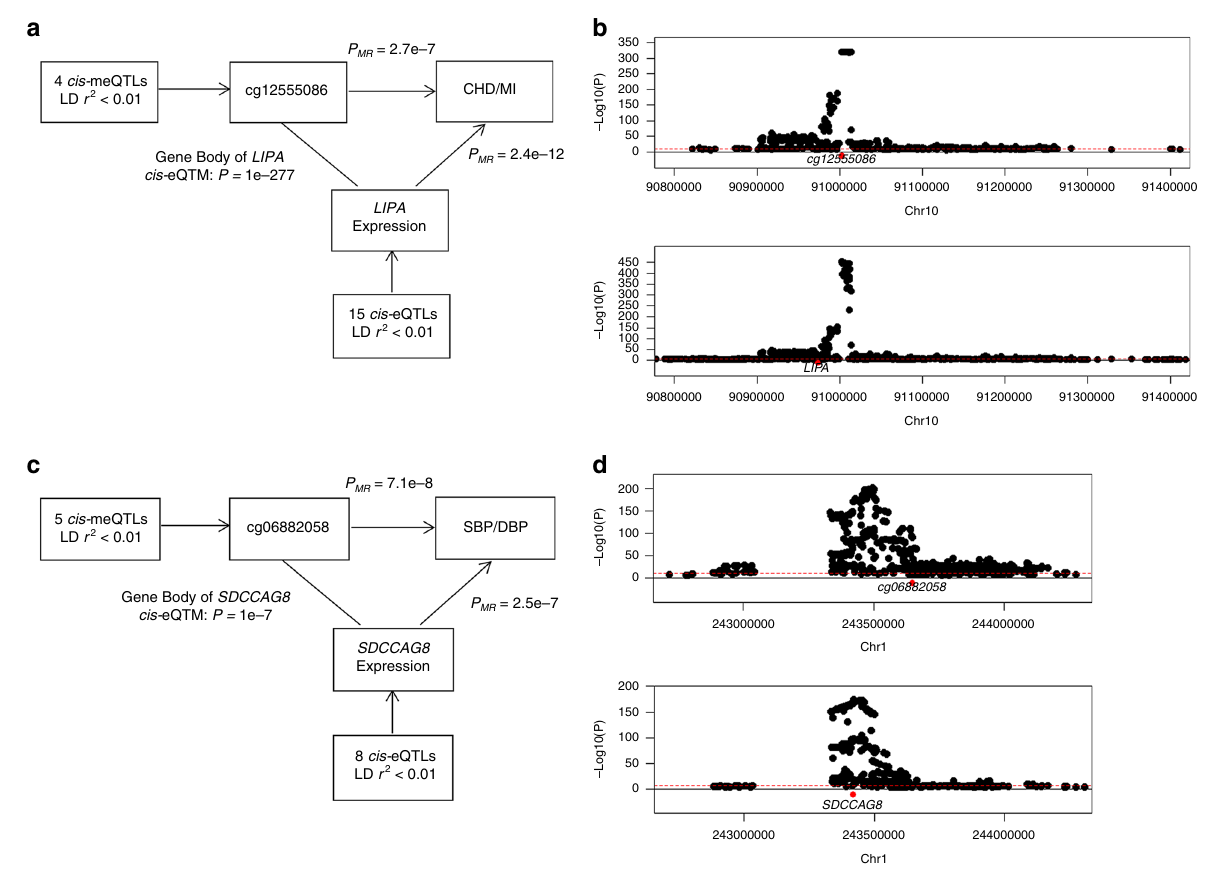
Fig. 6 Mendelian randomization examples. a MR example of cg12555086 in relation to CHD and MI; b colocalization of a casual cis- meQTL and a casual cis- eQTL on cg12555086 and LIPA expression; c MR example of cg06882058 in relation to SBP and DBP; d colocalization of a casual cis- meQTL and a casual cis- eQTL on cg06882058 and SDCCAG8 expression